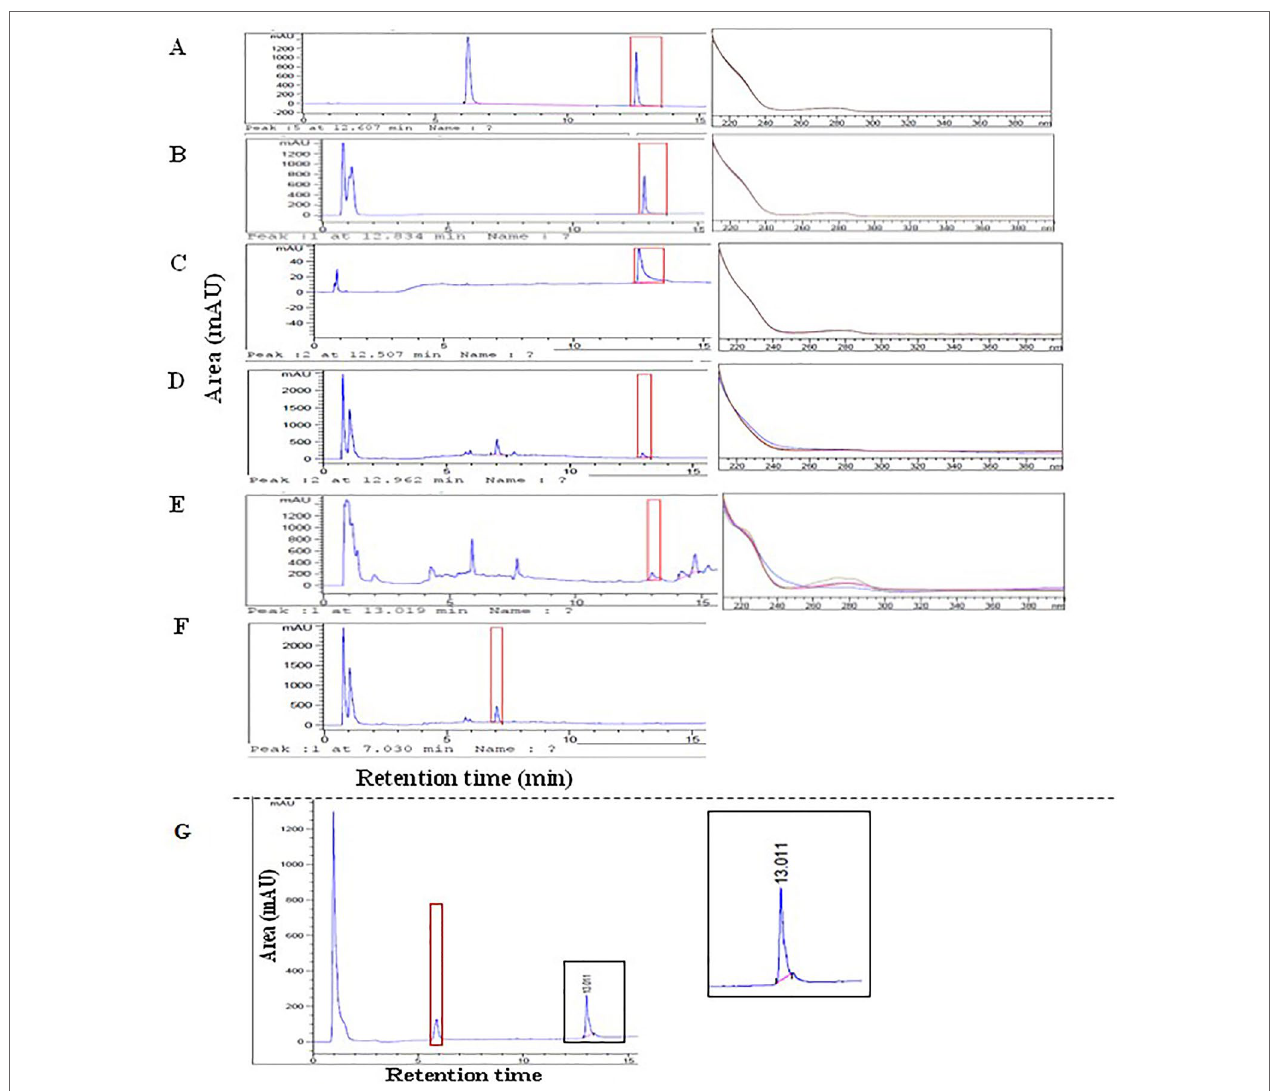
FIgUrE 6 | Chromatograms and UV spectra respectively from: (A) Commercial insulin 0.12 mg/ml (PISA, pharmaceutics); (B) EP insulin 0.2 mg/ml; (C) Bovine insulin 0.125 mg/ml; (D) NLE SCI-57; (E) NLE SCI-57 M2; (F) NLEN; (g) Chromatogram from NLE-SCI-57 (A2–A7 fractions) purification and concentration by ultrafiltration with 3 kDa membranes. All samples were diluted on citrate buffer pH